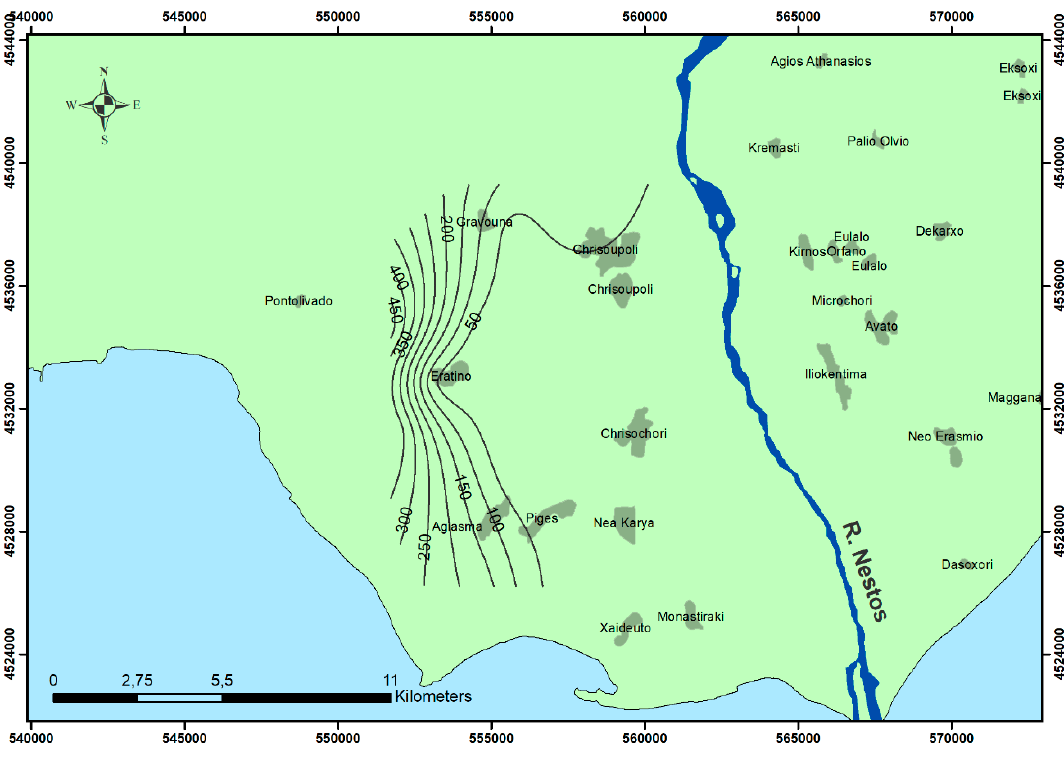
Hydrology 2022 , 9 , x FOR PEER REVIEW Figure 14. Chloride ion (Cl − ) distribution map (mg/L) of the unconfined aquifer (October 2019).